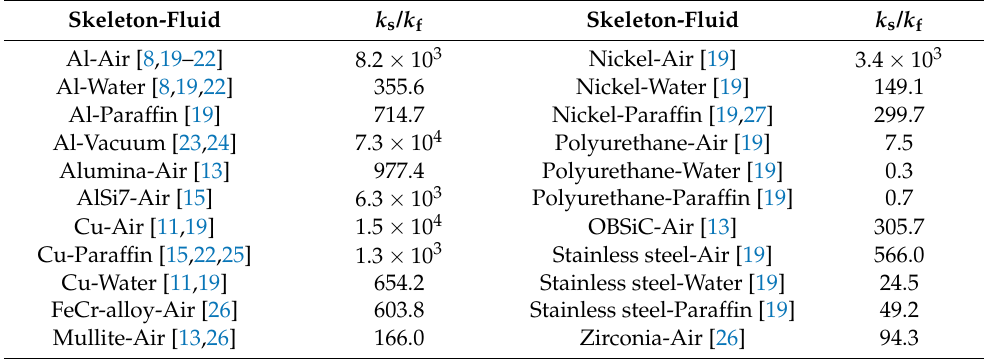
Table 3. List of references with published k eff values for different skeleton and filling media combina- tions and corresponding thermal conductivity contrast